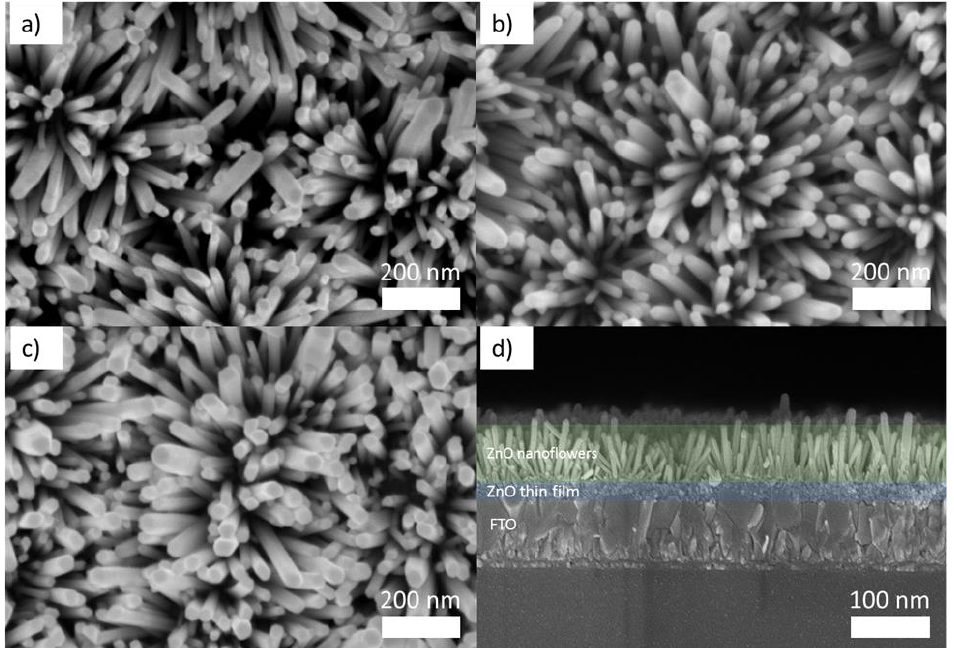
Figure 1. SEM images depicting the top view of ZnO NFs sputtered with ( a ) Ag, ( b ) Cu, and ( c ) Ti as well as ( d ) SEM image of the thin-film cross-section.